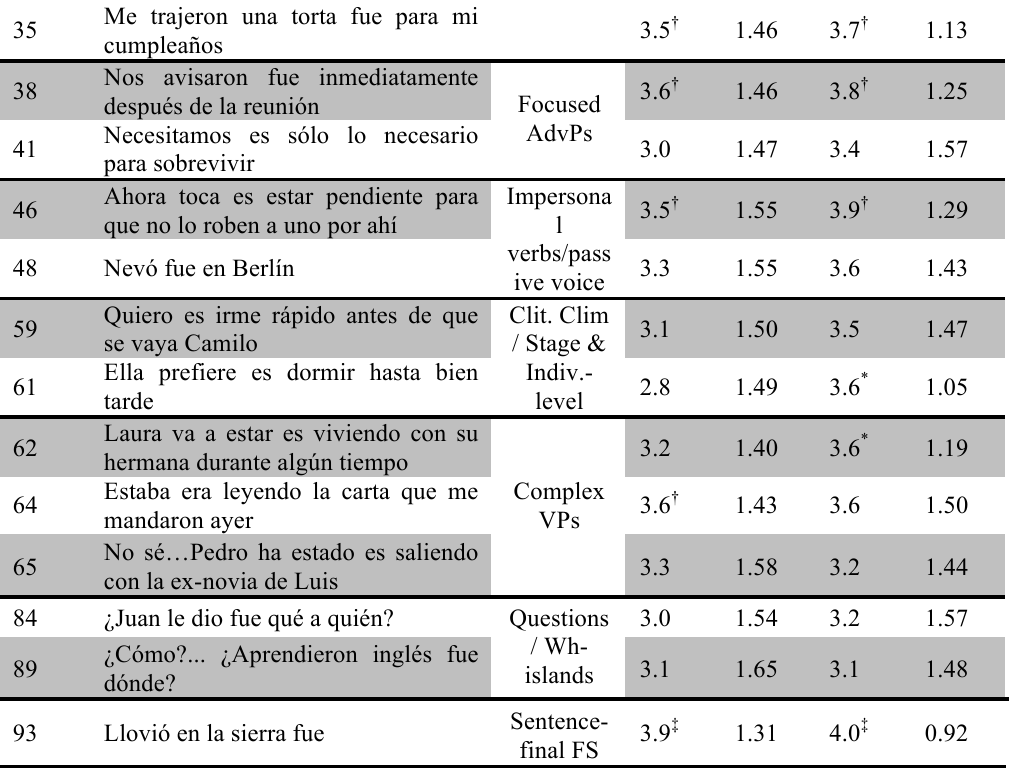
Table 3: List of most accepted cases of FS focus in the first